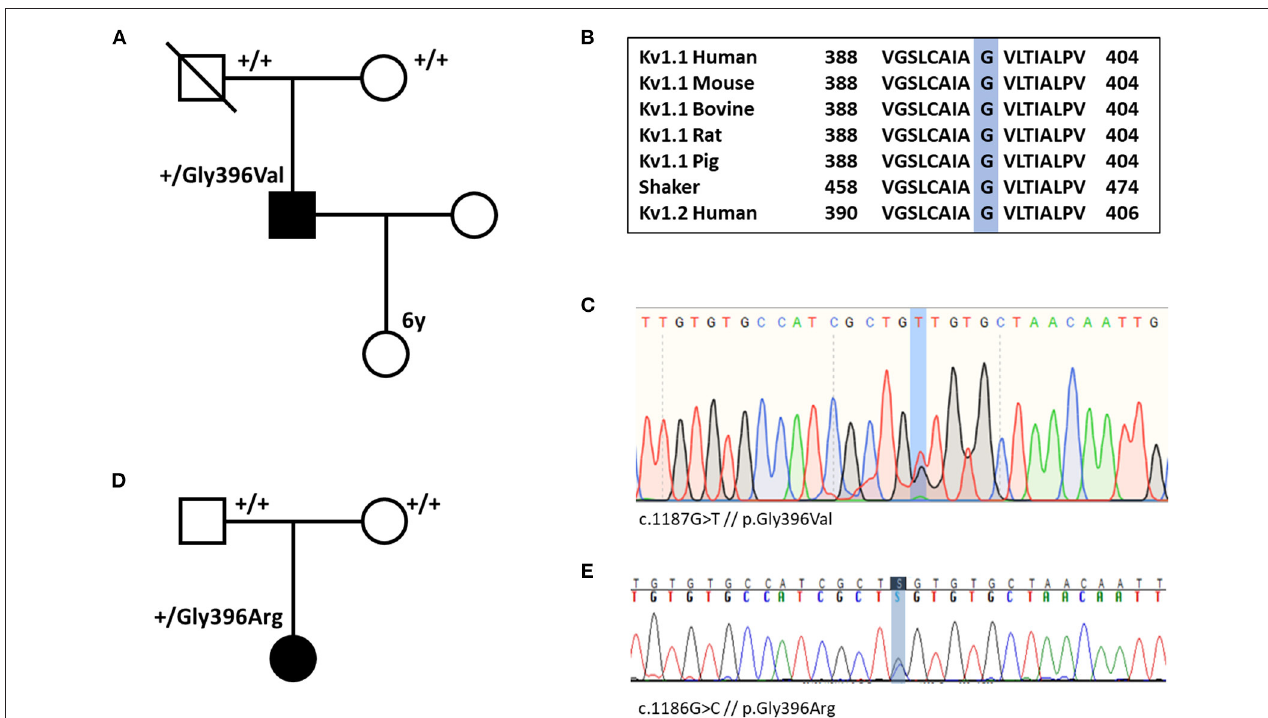
FIGURE 1 | (A) Pedigree of individual #1 shows that the variant p.Gly396Val (p.G396V) is de novo . (B) Amino acid sequence alignment of Kv1.1 subunits across several species and human Kv1.2 subunit demonstrates conservation of the Gly396 residue. (C) Nucleotide sequence with heterozygote substitution of G with T (c.1187G > T) in individual #1. (D) Pedigree of individual #2 demonstrates de novo status of the variant. (E) Nucleotide sequence with heterozygote substitution of G with C in individual #2 (c.1186G > C).